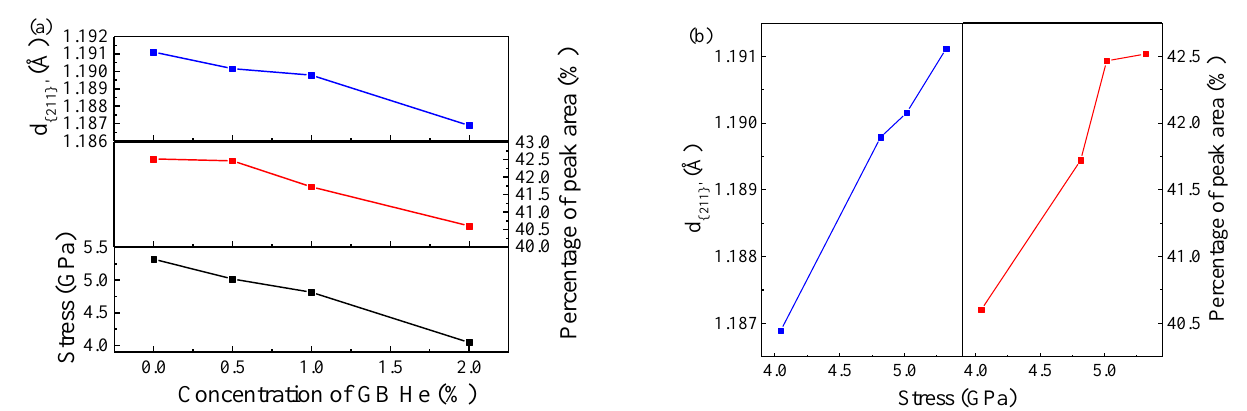
Figure 7. ( a ) The crystal spacing d {211}′ , the peak area of {211}′ and the stress as a function of He concentration for nanocrystalline Fe deformed to 6%; and ( b ) the crystal spacing d {211}' and the peak area of {211}′ as a function the stress for nanocrystalline Fe deformed to 6%.